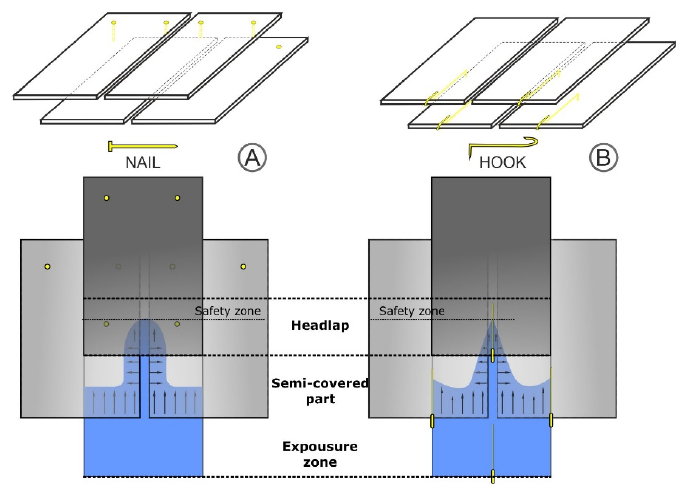
Figure 3. Attachment by nail ( A ) and hook ( B ), with their respective capillarity shapes.